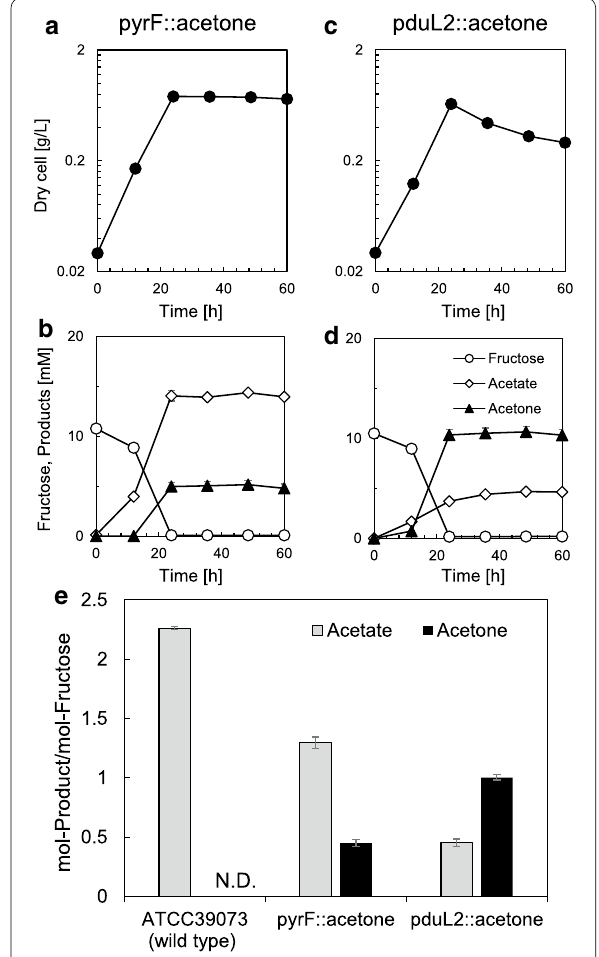
Fig. 2 Acetone and acetate production from fructose by the recombinant Moorella thermoacetica strains. a , c Dry cell weight according to the OD for the pyrF::acetone strain ( a ) and pduL2::acetone strain ( c ). b , d Concentration of fructose and excreted metabolites in the culture supernatant measured by HPLC for the pyrF::acetone strain ( b ) and the pduL2::acetone strain ( d ). Data represent the mean with SDs of three biological replicates. Most error bars are smaller than the symbols of data plots. e The acetone and acetate productivity per 1 mol of fructose is shown with black (acetone) and gray (acetate) bars. The productivity was calculated based on the measurement after complete consumption of the supplemented fructose. The parental strain, ATCC 39073 (wild type), which does not produce acetone is shown for comparison. Data represent the mean with SDs of three biological replicates